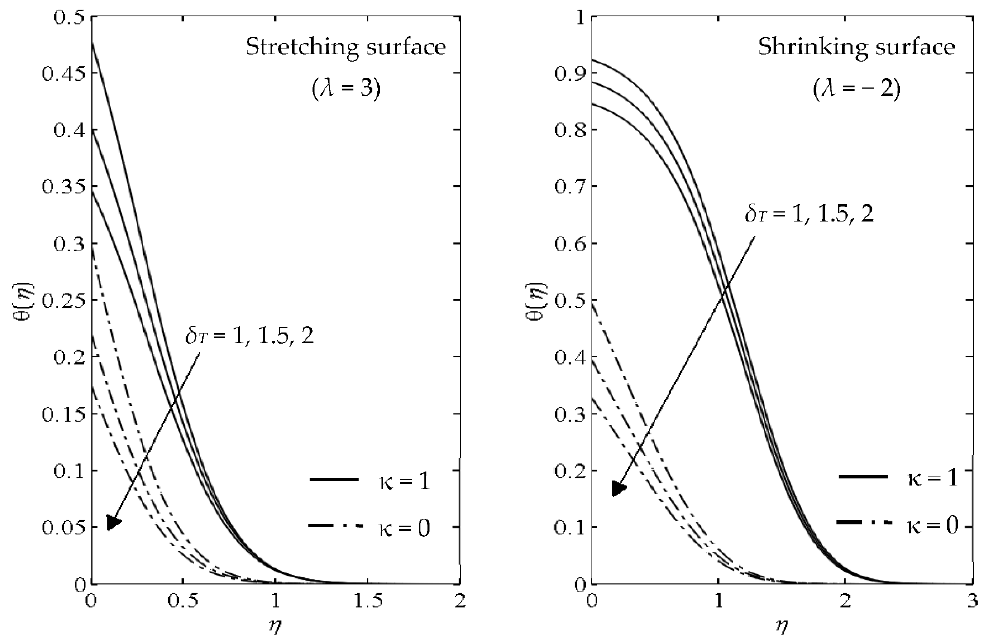
Figure 10. Effect of the velocity slip parameter, δ , on the velocity profiles for different parameters κ and λ .